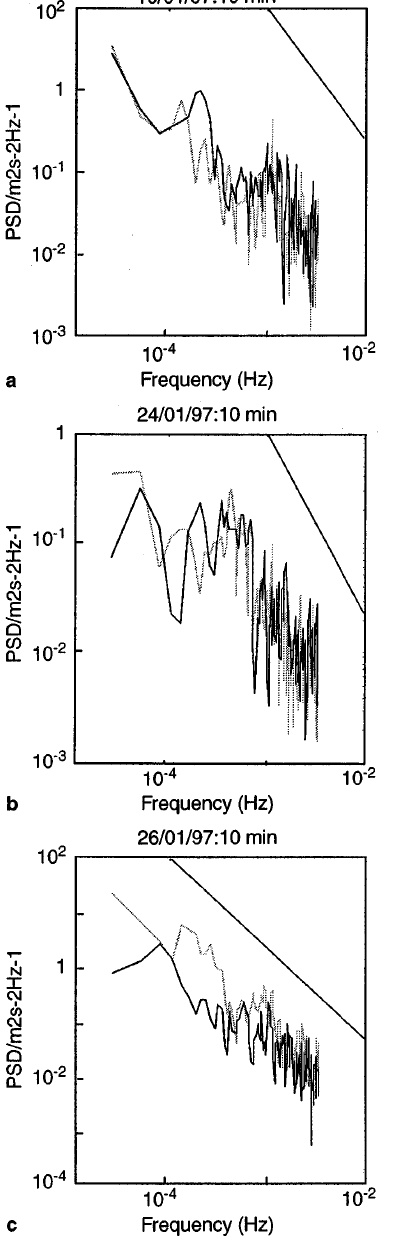
Fig. 13 a–c. For 10, 24 and 26 January, respectively: power spectral density of vertical wind fluctuations in the lower part of the troposphere (1–3 km) ( black ) and in the upper levels ( gray ) above 8 km for the 10th, above 10 km for the 26th and above 11 km for the